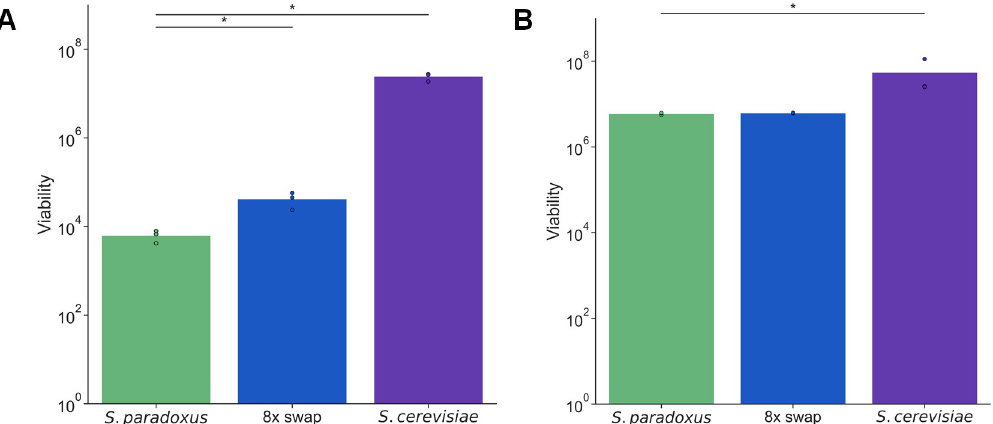
Fig 3. S . cerevisiae alleles of thermotolerance loci jointly improve heat survival during growth but not in stationary phase. In a given panel, each column reports viability after heat treatment of the wild-type of the indicated species, or the S . paradoxus strain harboring eight thermotolerance loci from S . cerevisiae (8x swap). The y -axis reports the number of colonies formed on solid medium from 1 mL of heat-treated liquid culture in (A) logarithmic growth or (B) stationary phase, normalized by turbidity. Points and bar heights report individual biological replicates and their means, respectively. � , Wilcoxon p � 0.05.